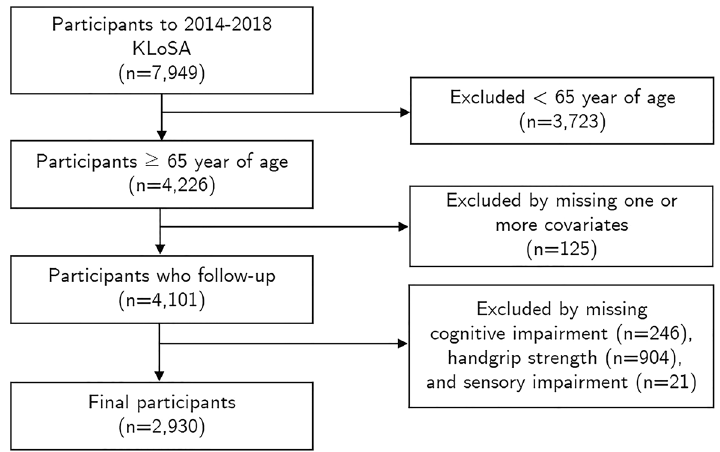
Figure 3. Flow of the selection process for this study sample. KLoSA Korean Longitudinal Study of